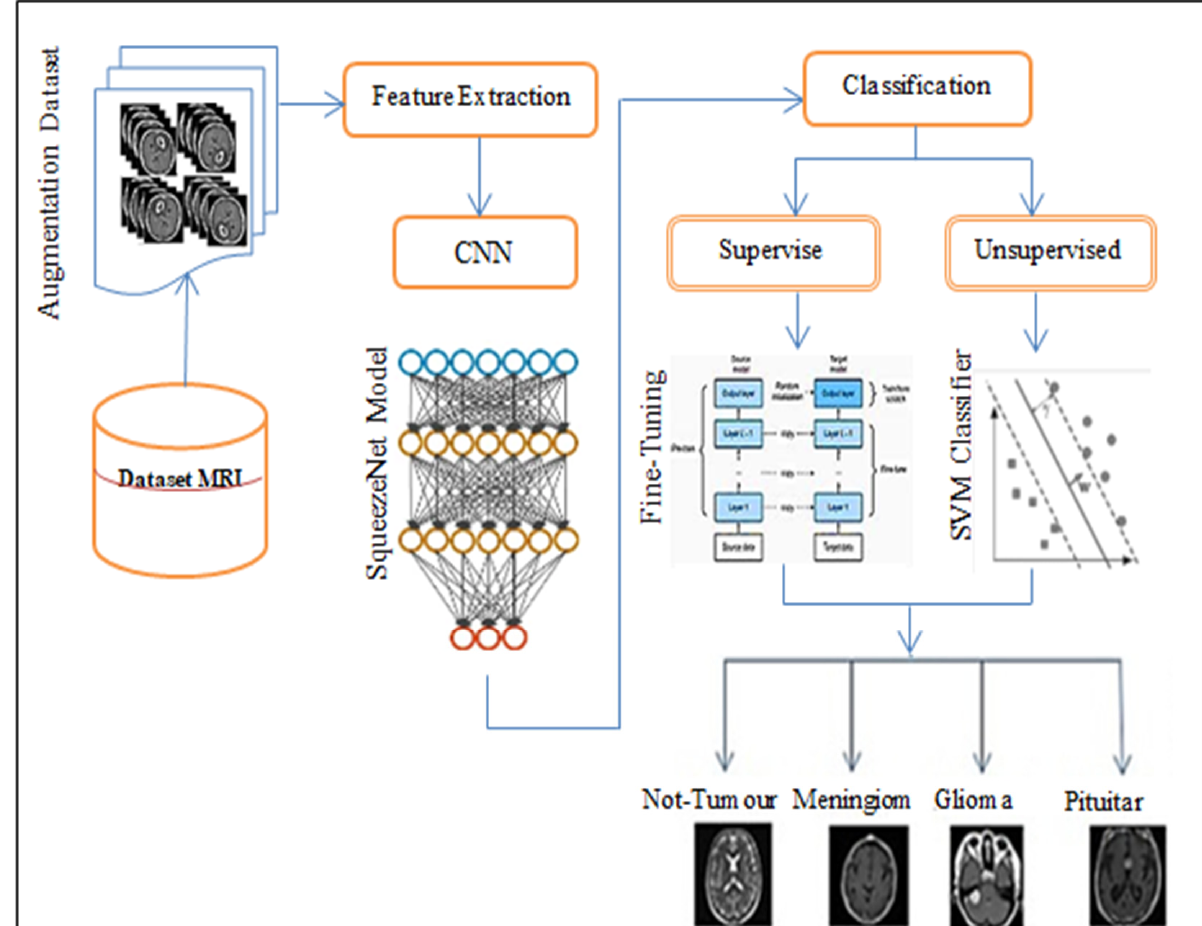
Figure 1. The proposed methodology.